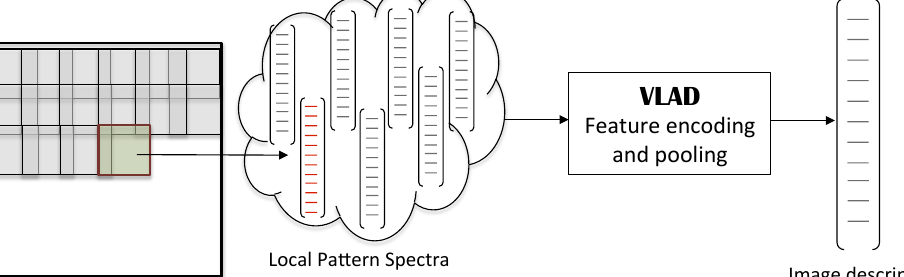
Figure 6. Overview of the feature extraction